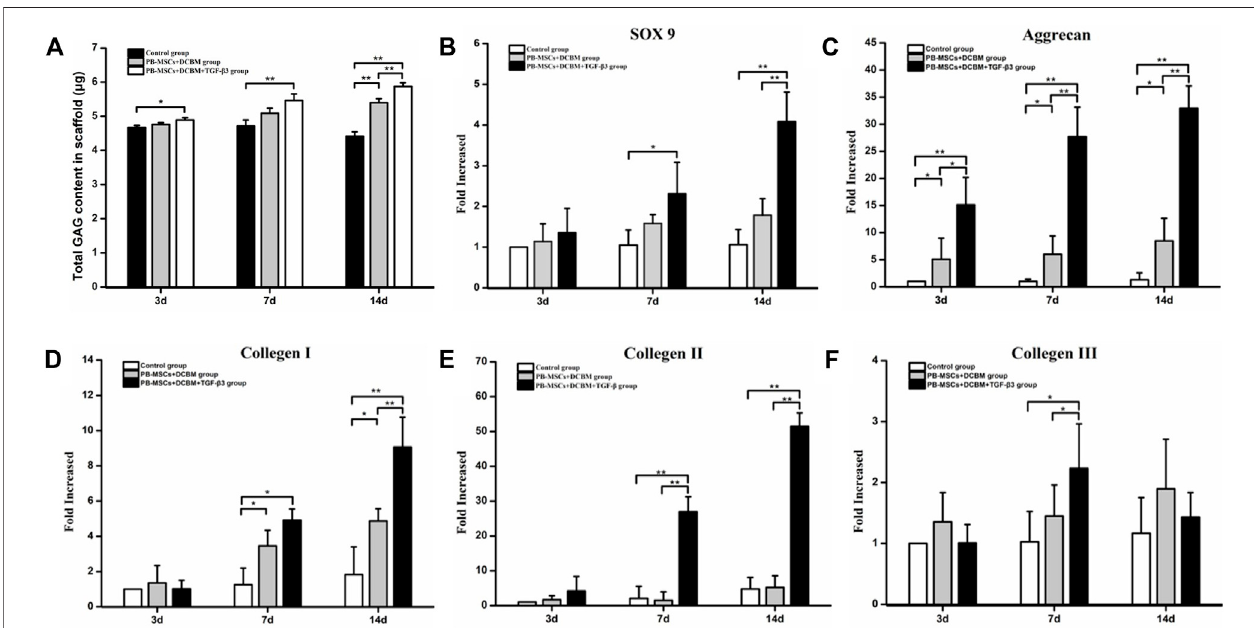
FIGURE 5 | Evaluation of differentiation capacity of PBMSCs on DCBM. (A) comparison of GAG production of different groups; real-time PCR analysis of genes expression of (B) SOX 9, (C) Aggrecan, (D) collagen Ⅰ , (E) collagen Ⅱ and (F) collagen Ⅲ of the PBMSCs seeded on DCBM. * p < 0.05, ** p <